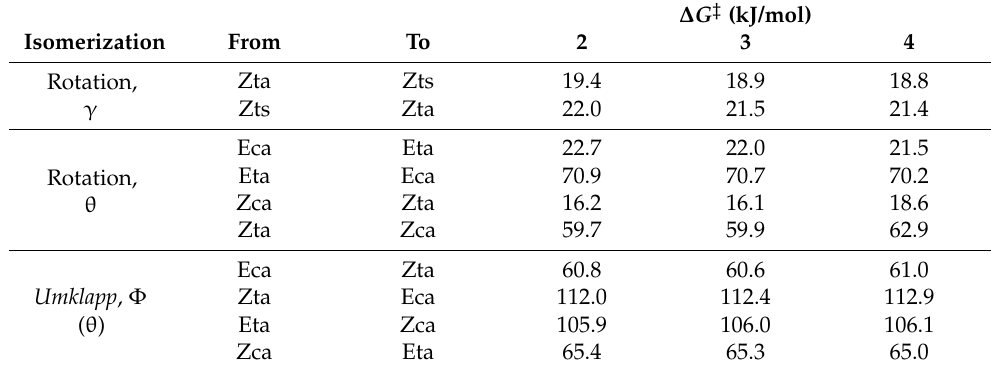
Table 10. Free energy activation barriers, ∆ G ‡ , calculated at the ω B97M-D4/cc-pVTZ level, and corresponding rate constants at 298 K for selected isomer interconversion processes of 2 – 4 . The barriers are grouped with respect to the interconversion